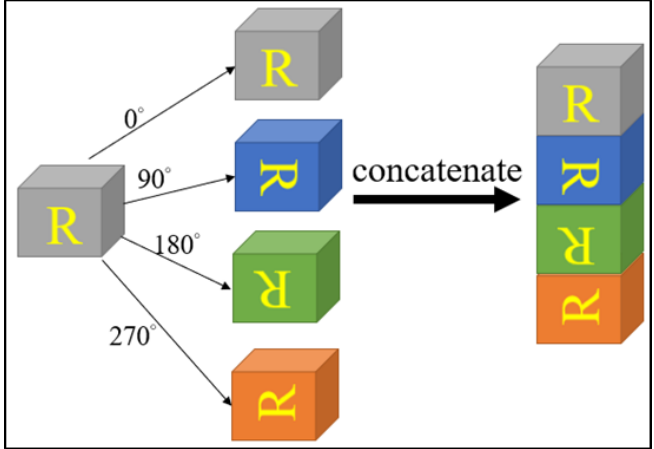
Figure 11. Fixed-angle rotation.